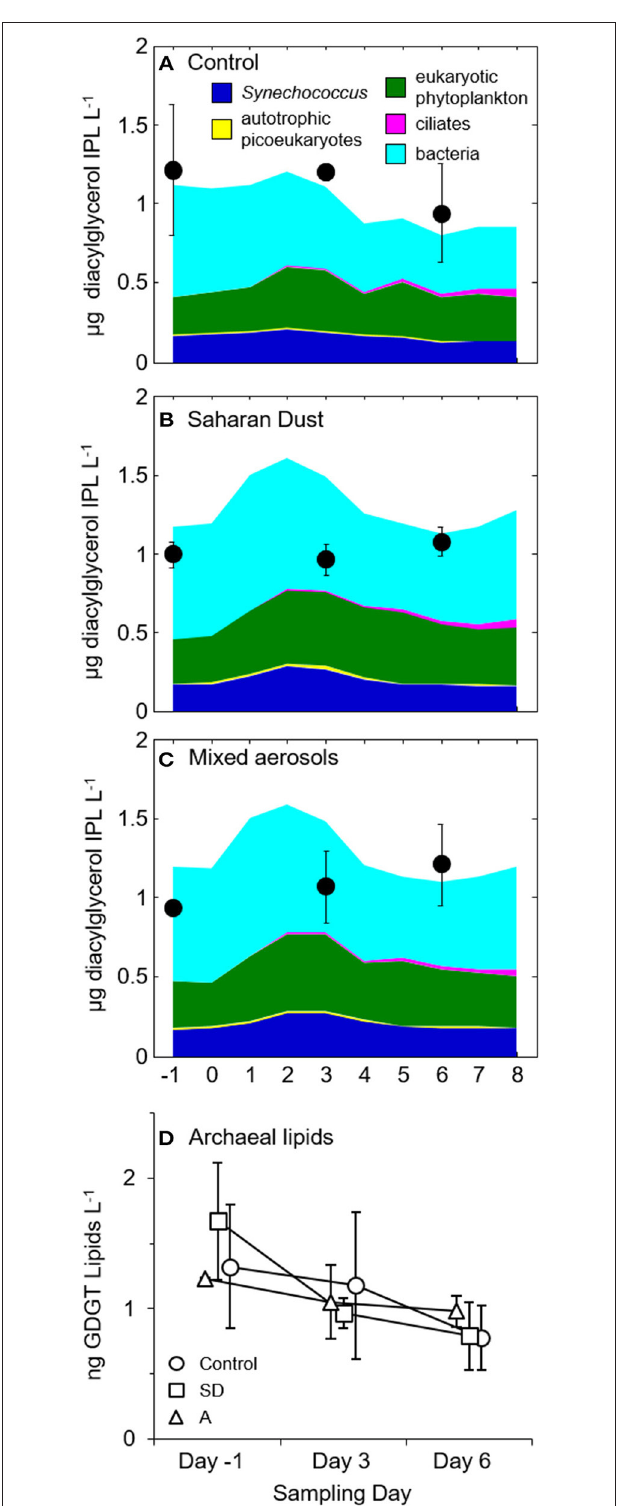
FIGURE 1 | Predicted (colored areas) and measured (black circles) IPL concentrations in (A) control, (B) Saharan dust, and (C) mixed aerosol mesocosms. Error bars represent the standard deviation of replicate